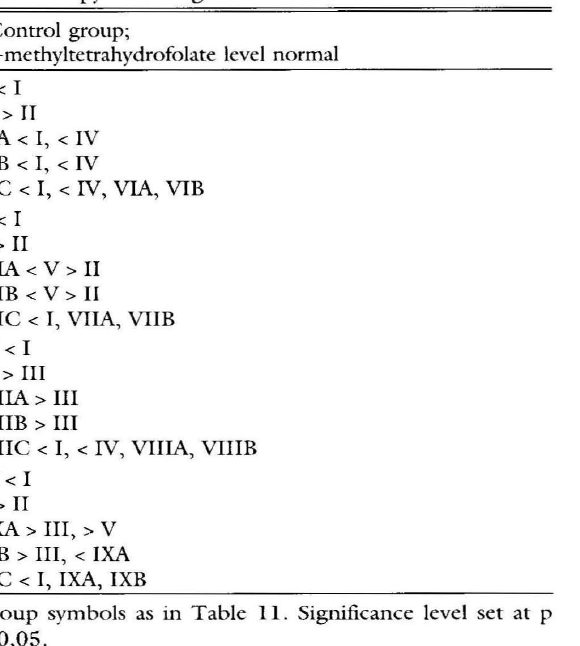
Table II. N 5 -methyltetrahydrofolate levels In erythro cytes of BDF, mice after administration of MTX, FU and combined therapy according to different schedules